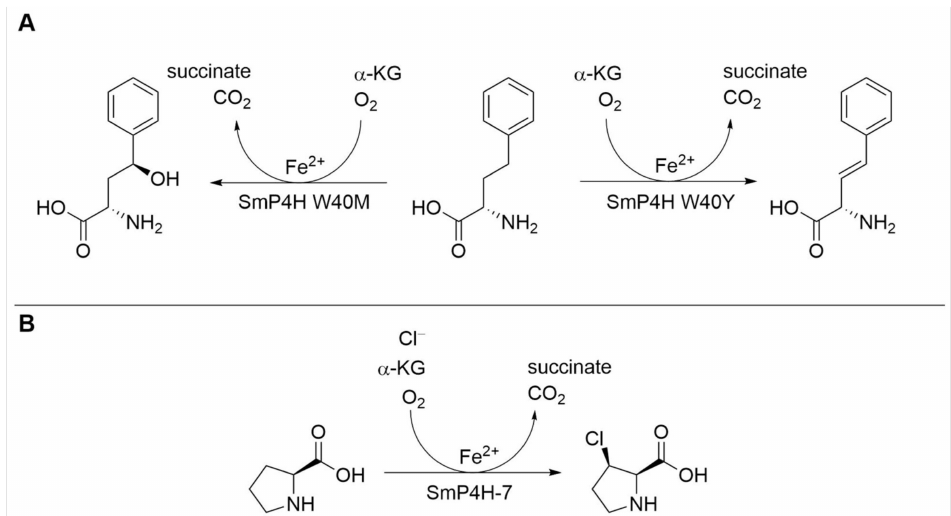
Figure 5. Biocatalytic reactions of the L -proline cis -4-hydroxylase SmP4H from Sinorhizobium meliloti. ( A ) Engineered enzymatic reaction for hydroxylation or desaturation of L -homophenylalanine [20]. ( B ) Engineered enzymatic reaction with chlorination activity